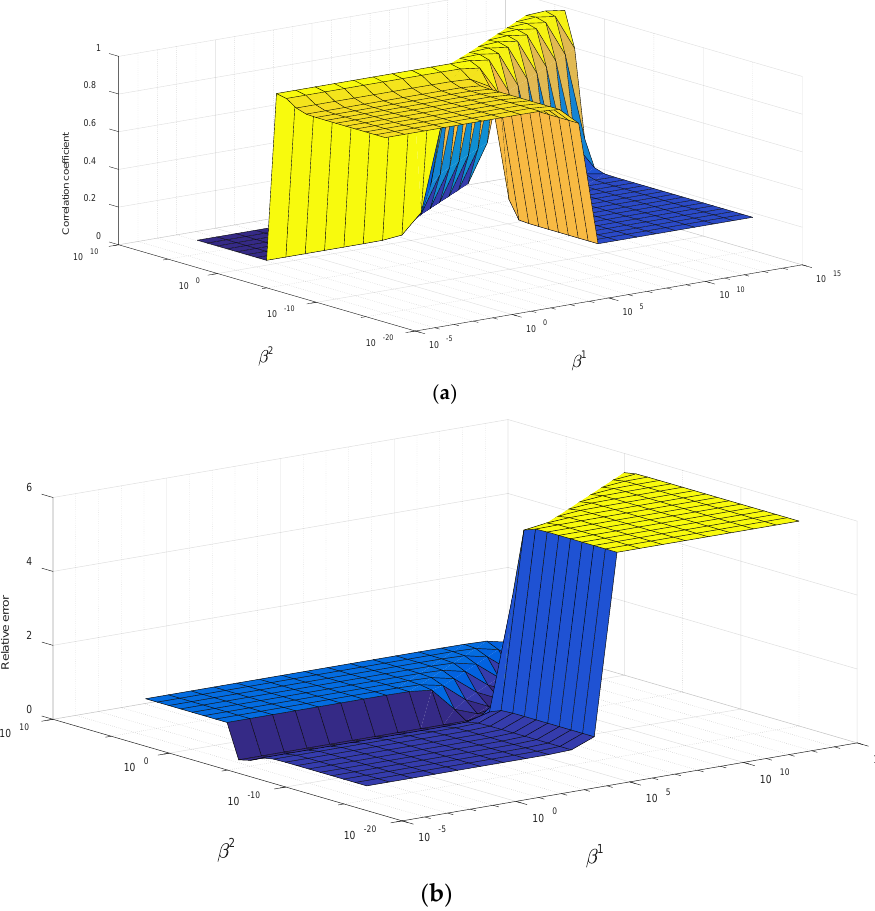
β , β β . ( b ) Relative error varies with the 2 . ( b ) Relative error varies with the 1 , 1 2